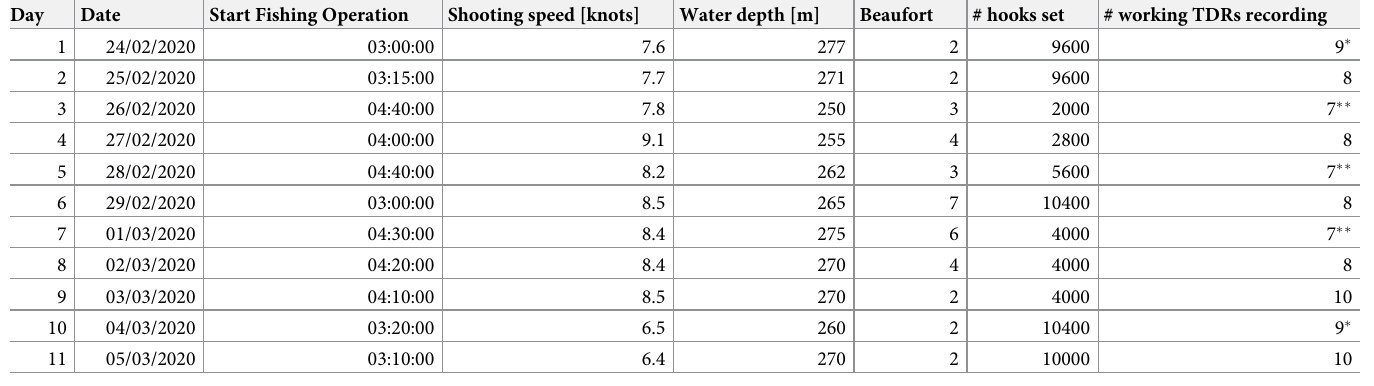
Table 1. Summary of TDRs deployment with gear configuration and fishing